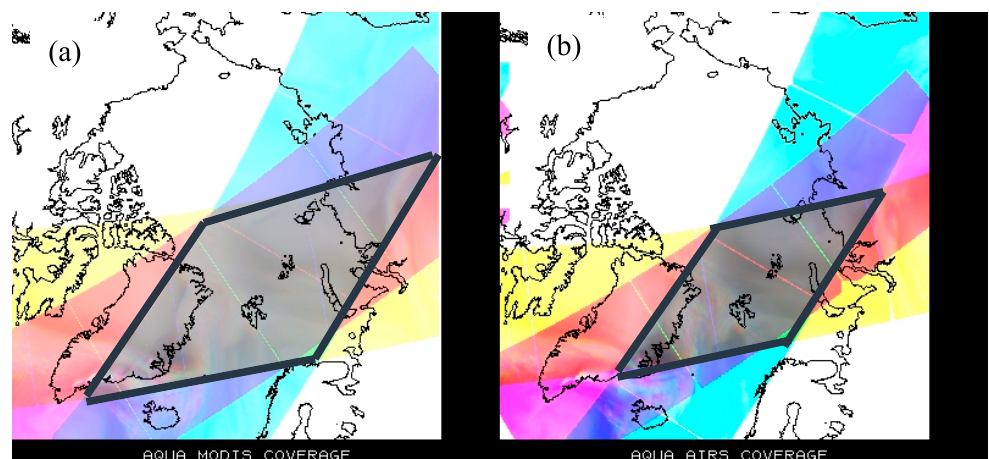
Figure 3. Three successive overlapping passes (each separated by 100 min) of radiance images from the ( a ) Aqua Moderate Resolution Imaging Spectroradiometer (MODIS) and the ( b ) Atmospheric Infrared Sounder (AIRS). The region of intersection (gray parallelograms) shows where features can be tracked. The input data files are three time-ordered humidity or ozone concentration images, each separated by one orbit (100 min), on many di ff erent pressure levels and forecast model output. Three images